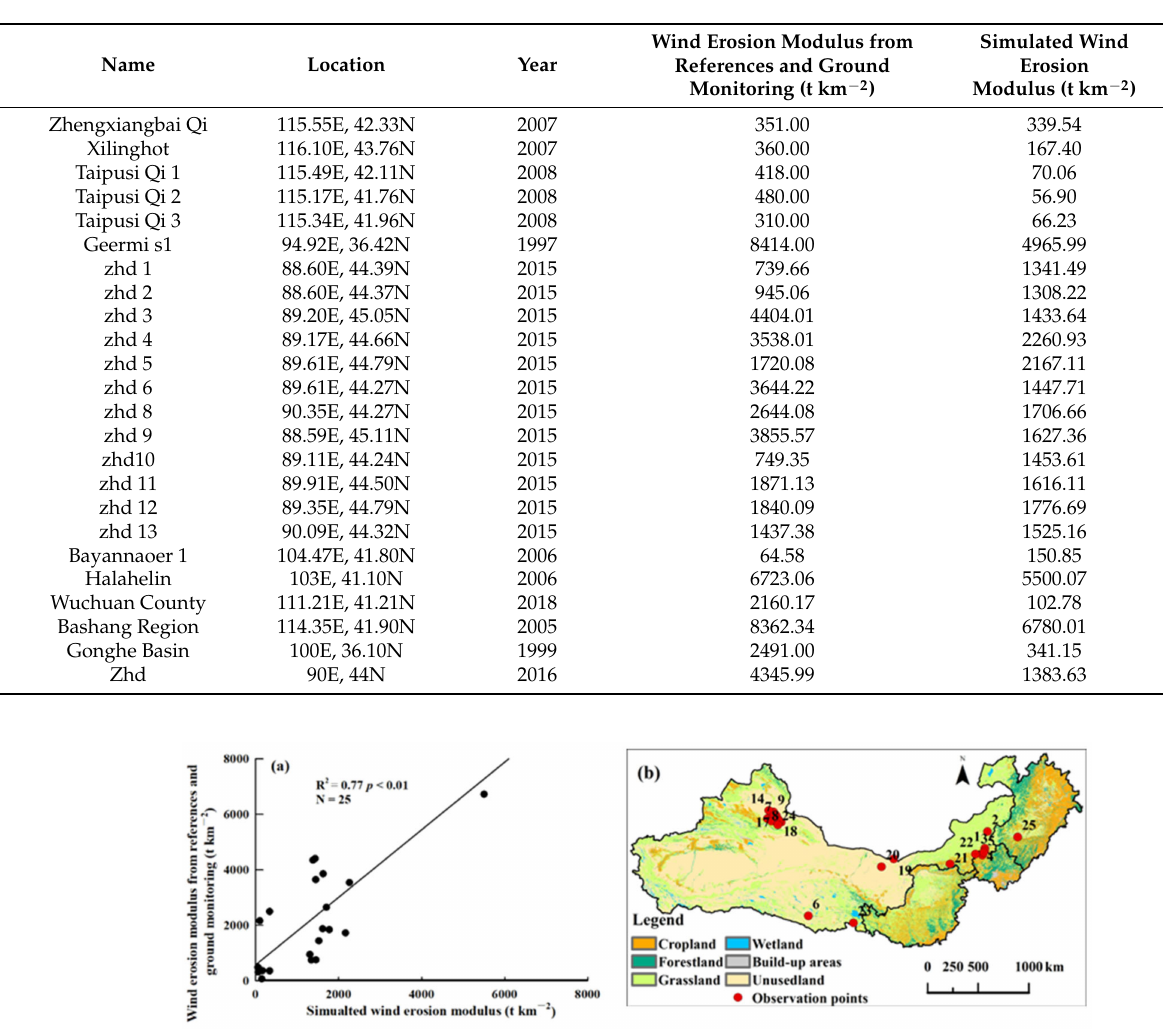
Figure 2. ( a ) Model accuracy test of the wind erosion modulus and ( b ) distribution of field points across the TNR of China (the number of the observation point is the ID of Table 1).